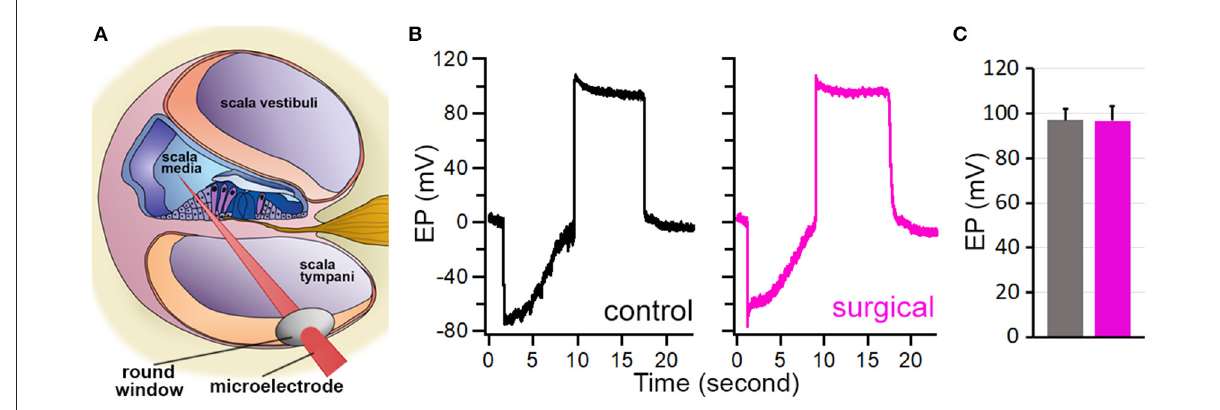
FIGURE5 EP measured from control and surgical ears. (A) Schematic drawing of EP measurement. (B) Representative EP measured from control and surgical ears. (C) Mean ± SD of EPs measured from control and surgical ears. No statistical difference was found ( p = 0.72, n = 6).